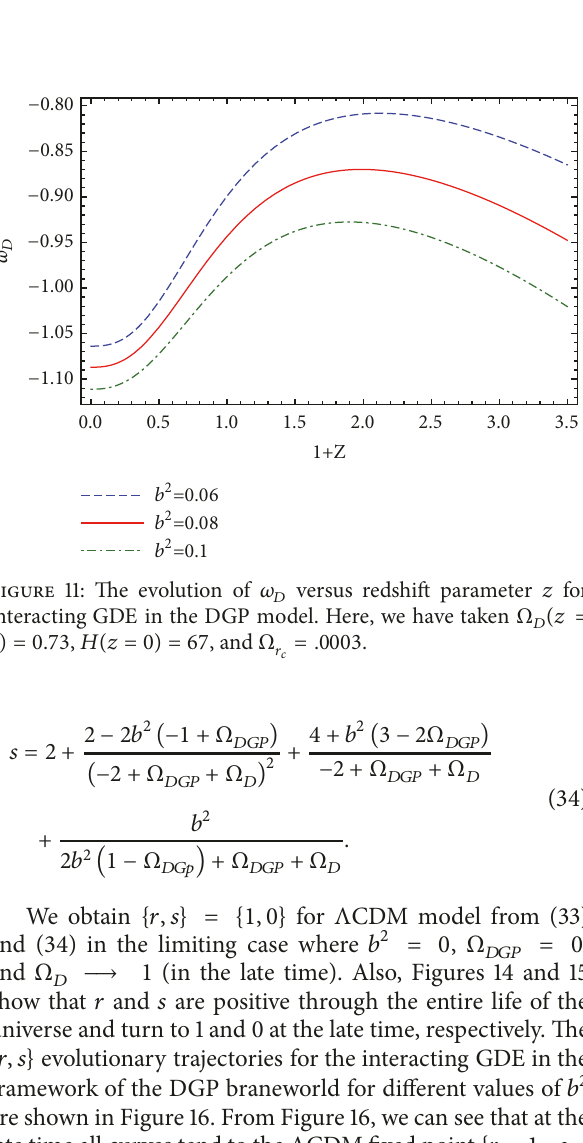
Figure 9: The 𝜔 𝐷 − 𝜔 󸀠 𝐷 diagram for noninteracting GDE in the DGP model. Here, we have taken Ω 𝐷 (𝑧 = 0) = 0.73 , 𝐻(𝑧 = 0) = 67 , and Ω = 0.0003. 𝑟 𝑐